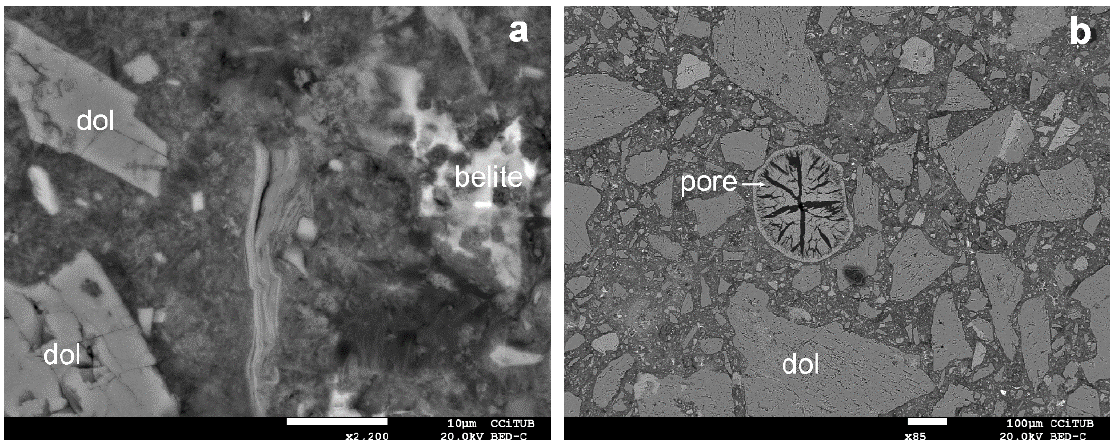
Figure 9. Backscattered-Scanning Electron Microscopy image of type B concrete. ( a ) Elongated illite crystal showing exfoliation planes, nodules of belite, and dolomite particles showing rhombohedral exfoliation imbibed in the cement paste; ( b ) regular distribution of dolomite particle of aggregate and fibrous crystals of ettringite filling a pore imbibed in the cement paste.